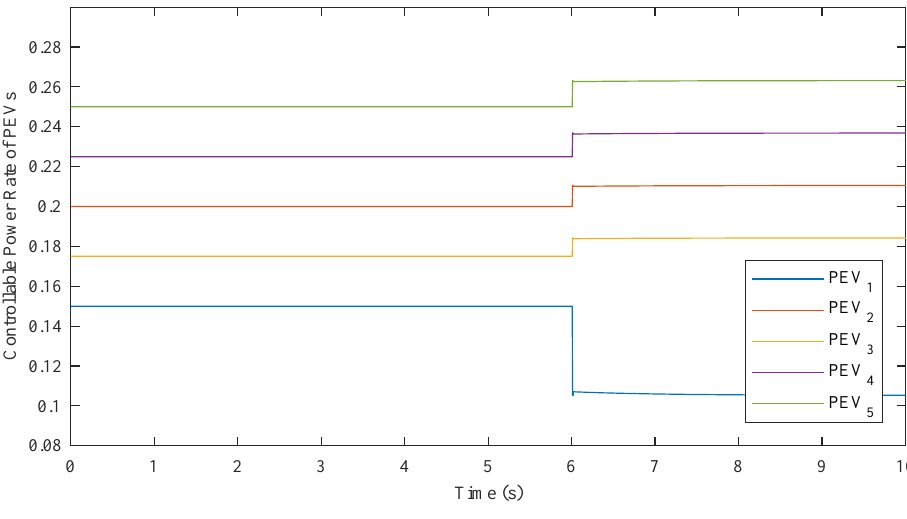
Figure 13. Controllable power rate of